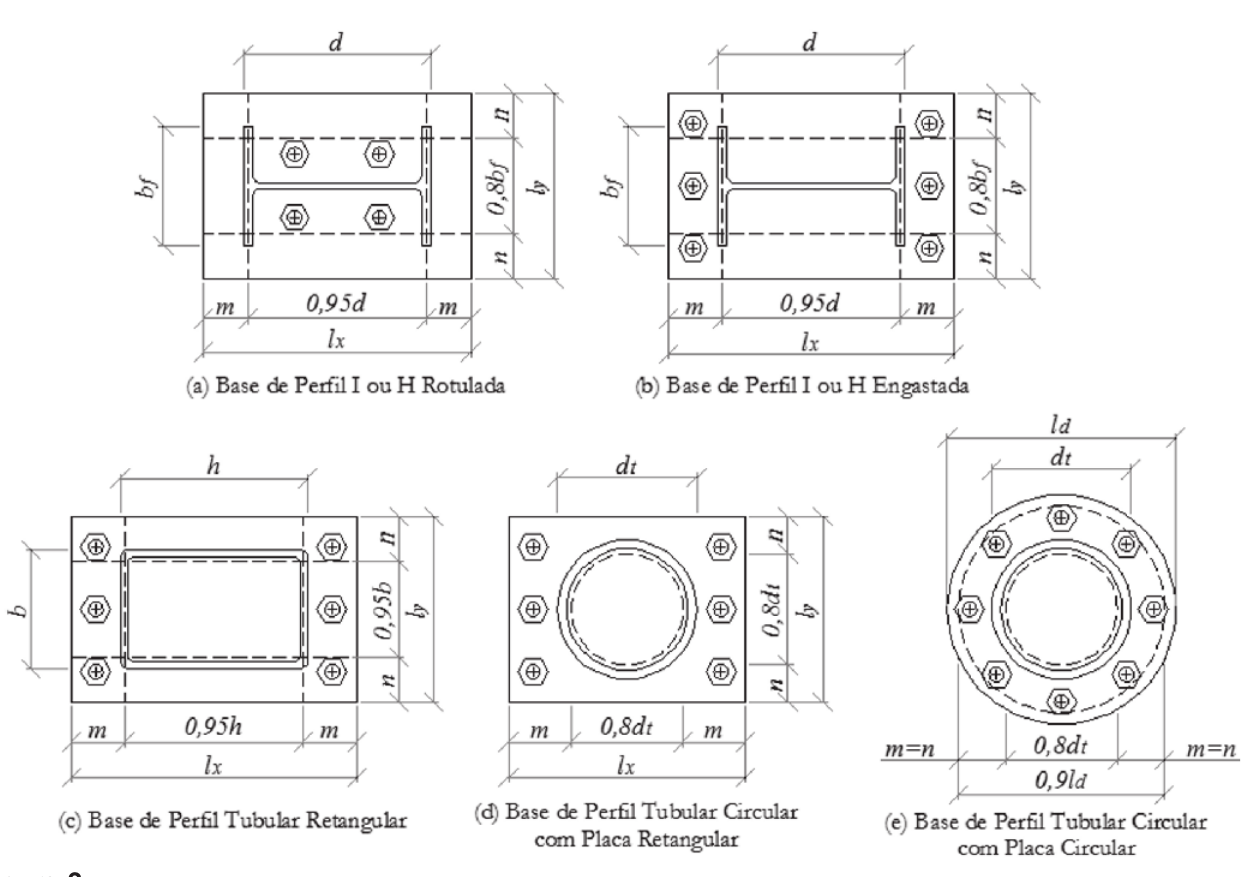
Figura 2 Tipos de bases de pilares de